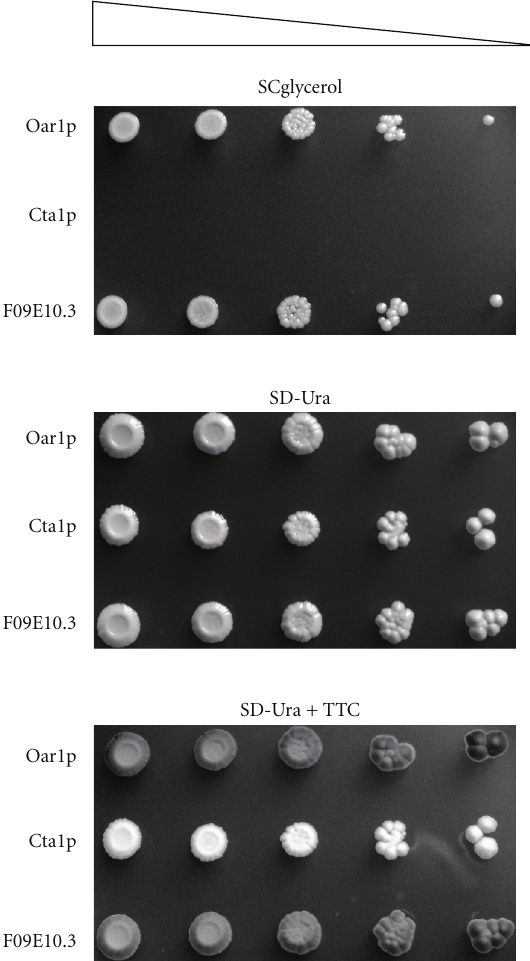
Figure 2: Phenotype rescue of a yeast oar1 Δ strain expressing F09E10.3. Mutant S. cerevisiae BY4741 oar1 Δ cells producing native mitochondrial Oar1p (positive control), peroxisomal catalase A Cta1p (negative control), or the nematode mitochondrial protein F09E10.3 (tester strain), were grown on SD-Ura medium selecting for plasmid presence, and following tenfold serial dilution (tri- angle) were spotted onto the indicated solid media. Respiration competence was examined by applying 2,3,5-triphenyltetrazolium chloride (TTC) as an overlay to the SD-Ura